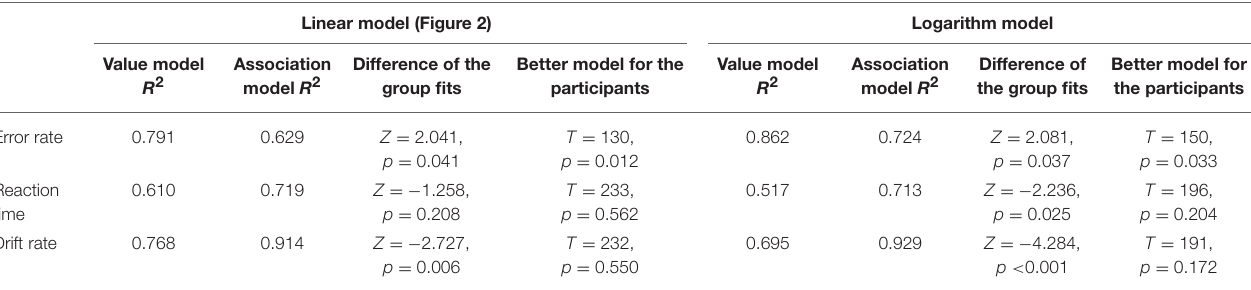
TABLE 3 | Goodness of fit of the models (measured as R 2 ) and comparison of the correlations (Difference column) for the error rates, reaction times, and drift rates patterns based on the group average data, and hypothesis tests for choosing the better model based on the participants’ data in the replication study.